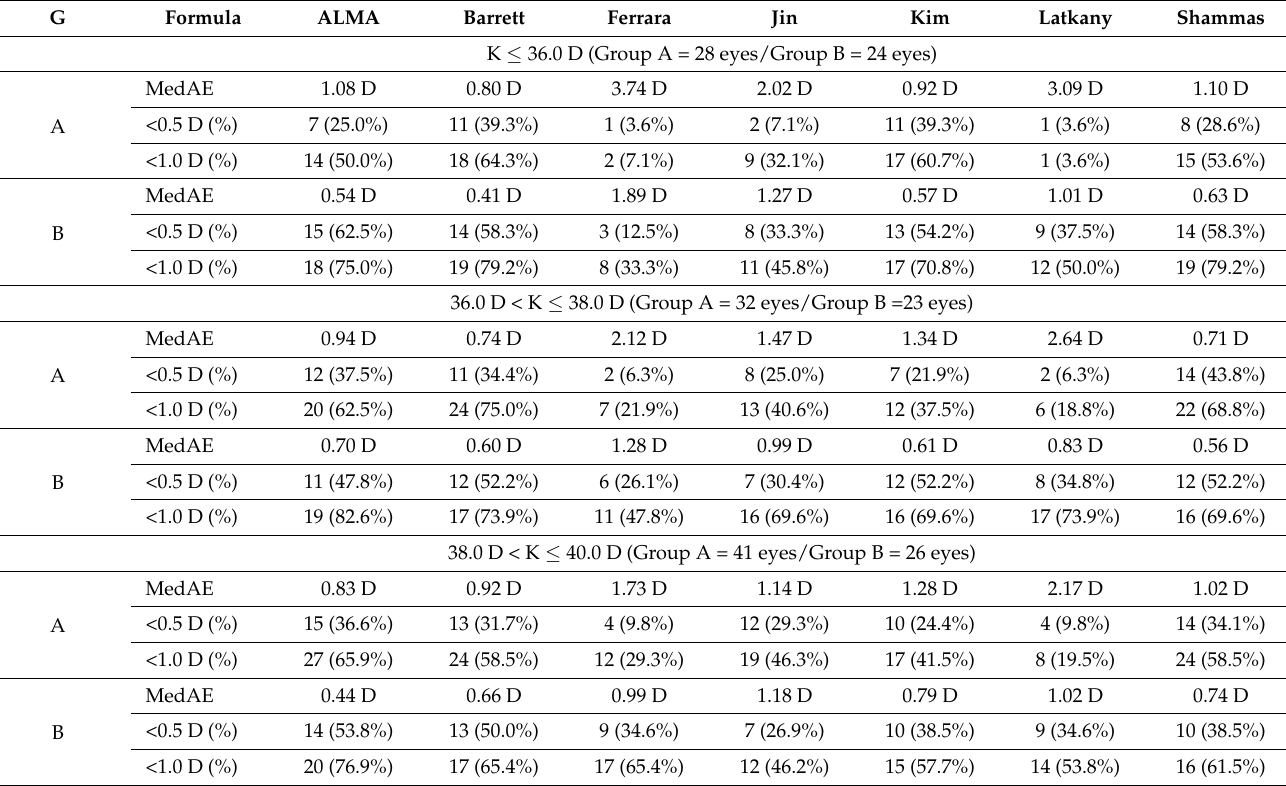
Table 2. Comparison of refractive outcome among examined formulas according to different mean keratometry (K) ranges. (Group A and